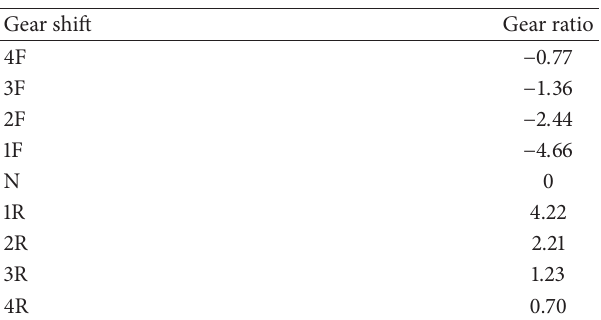
Table 1: Transmission